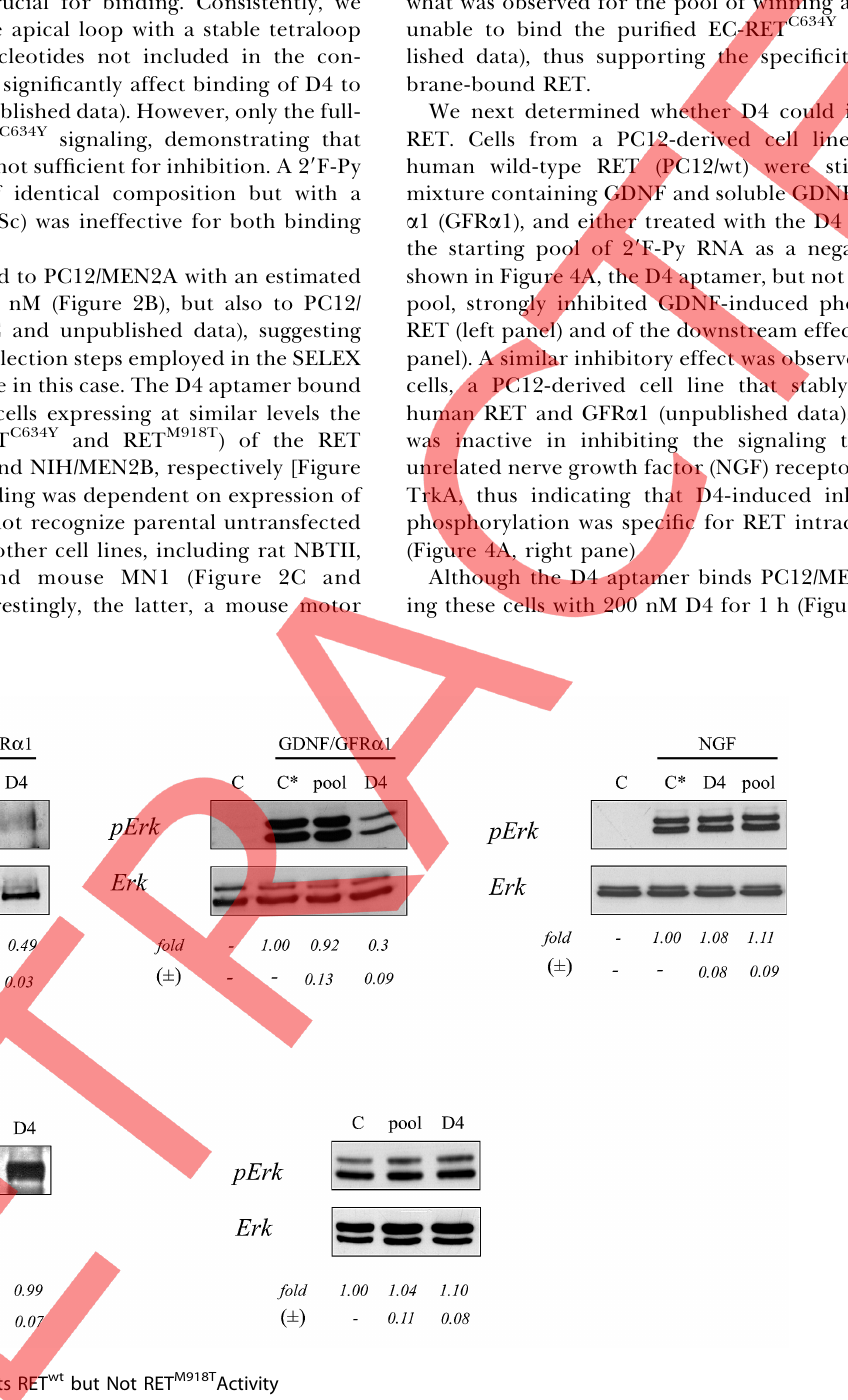
Figure 4. D4 Aptamer Inhibits RET wt but Not RET M918T Activity (A) PC12/wt cells were treated for 10 min with GDNF (50 ng/ml) and soluble GFR a 1 (1.6 nM), or 5 min with NGF (100 ng/ml), together with 200 nM of either the D4 aptamer or the starting RNA pool. ‘‘ C* ’’ indicates cells treated with GDNF and GFR a 1 in the absence of aptamer. (B) PC12/MEN2B cells were starved for 6 h and then treated for 1 h with 200 nM D4 or the starting RNA pool. Cell lysates were immunoblotted with anti-(Tyr-phosphorylated)-RET or anti-(phospho)-ERK antibodies, as indicated (see Figure 3 legend). In (A) and (B), ‘‘ C ’’ indicates mock-treated cells. Quantitations were done as in Figure 3, and relative abundances are expressed relative to controls, arbitrarily set to 1. Standard deviations are indicated ( n =